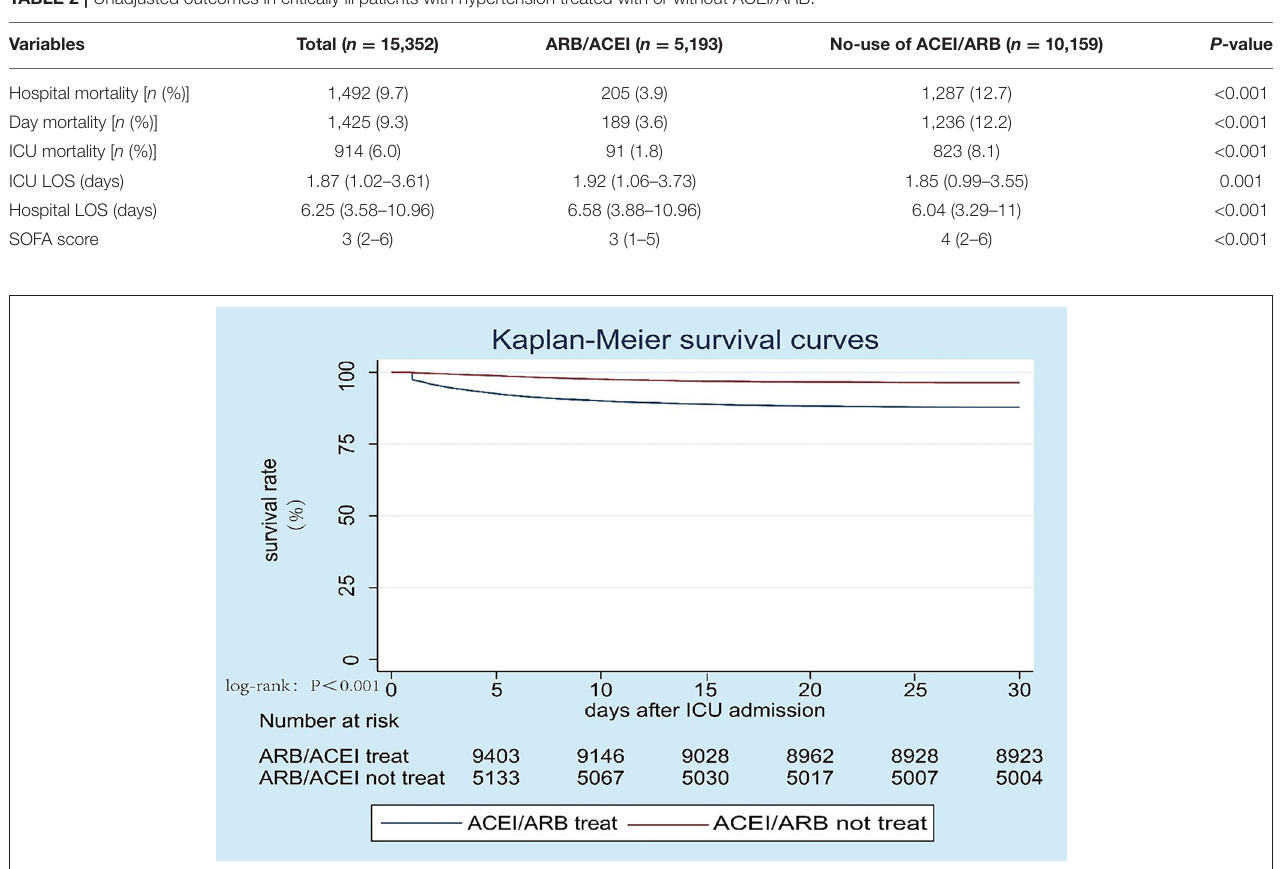
WBC [9.8 (7.6–12.6) vs. 10.0 (7.5–13.4)] and Chloride [103.7 (100.5–106.6) vs. 104.0 (101.0–107.0)] were lower than